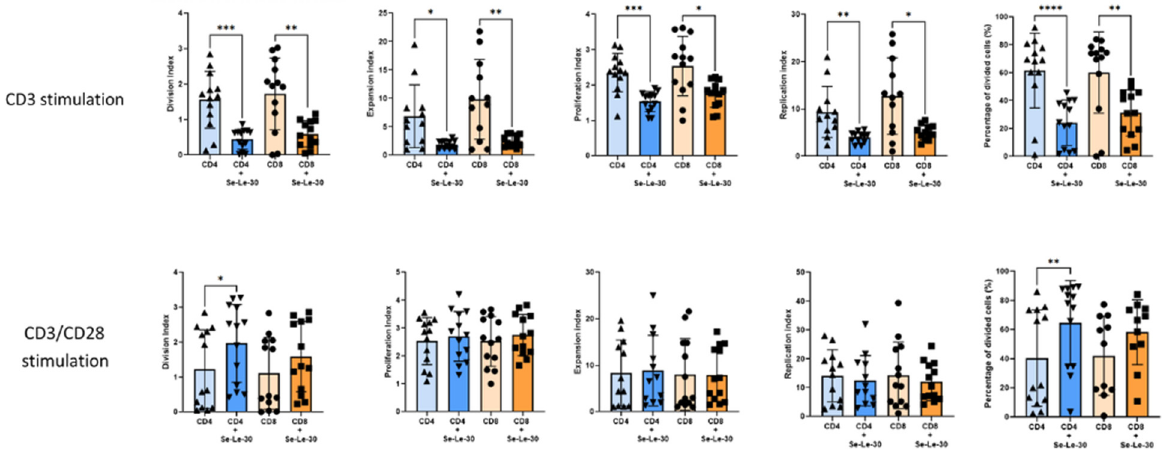
Figure 1. Effects of Se-Le-30 on the proliferation of human CD4 + and CD8 + T cells stimulated with anti-CD3 Ab (top row) and anti-CD3/CD28 Abs (bottom row). PBMCs from 13 healthy donors were stimulated and treated with Se-Le-30 (100 µ g/mL) for 5 days. In each experiment, the division index, proliferation index, expansion index, replication index, and percentage of divided cells were calculated by using FlowJo software. Statistical differences were considered when p < 0.05. * p < 0.05; ** p < 0.01; *** p < 0.001; **** p < 0.0001. Points on bar charts represent experiments conducted with individual donors.